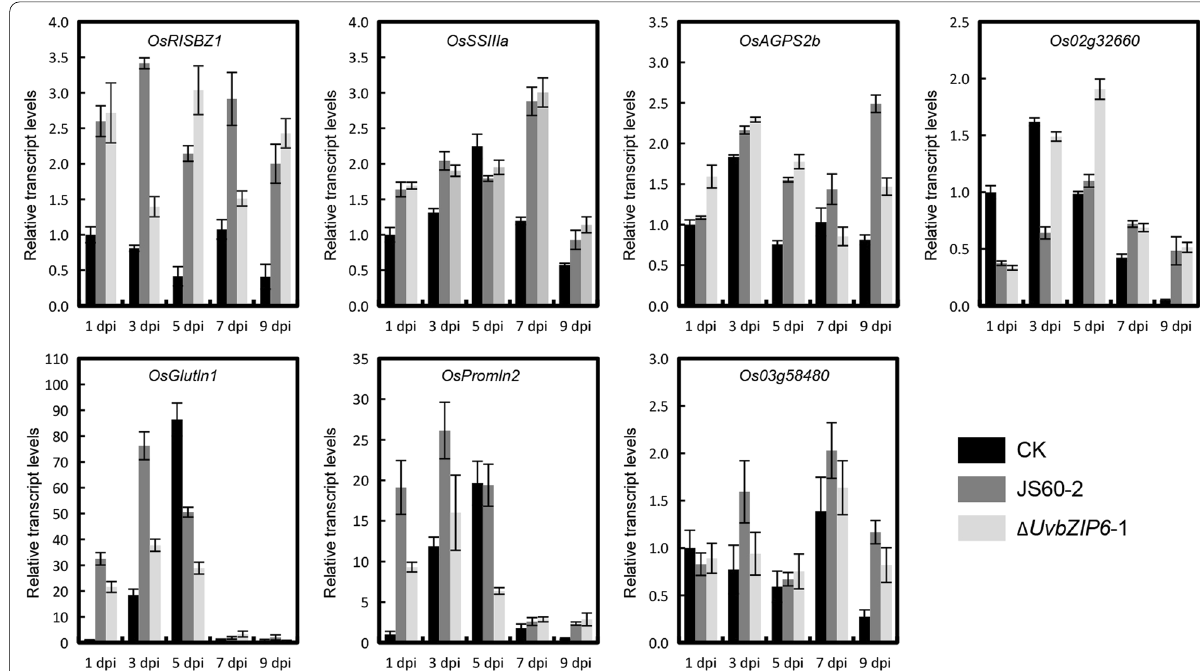
Fig. 7 Expression profiles of 7 rice filling-related genes after inoculation with the WT or UvbZIP6 -knockout mutant. The expression levels of the genes were detected at 1, 3, 5, 7, and 9 dpi. Rice plants inoculated with sterile ddH 2 O were used as control (CK). The GAPDH gene was used as the internal reference. The expression level for CK at 1 dpi was normalized to